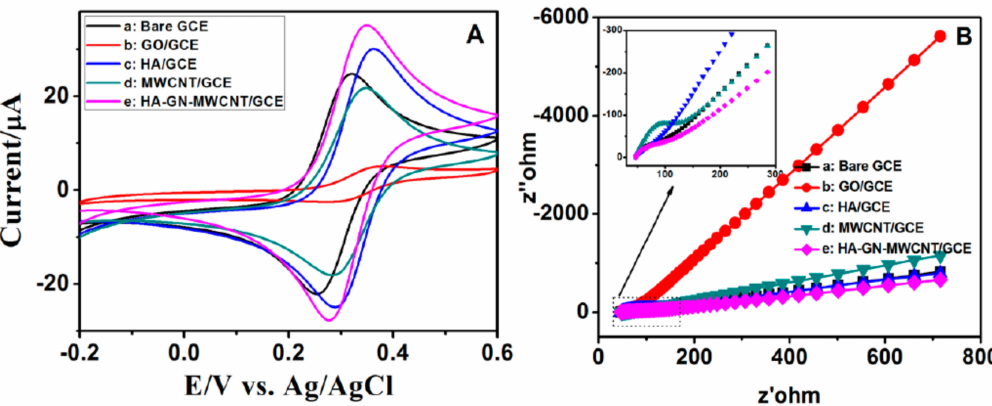
Figure 6. ( A ) CVs of ( A ) bare GCE, (b) GO, (c) HA, (d) MWCNT, (e) HA-GN-MWCNT modified GCEs in 1 mM [Fe(CN) 6 ] 3 − / 4 − at a scan rate of 50 mV / s. ( B ) Electrochemical impedance spectra of the corresponding electrodes recorded at the DC potential of 200 mV, AC potential ± 5